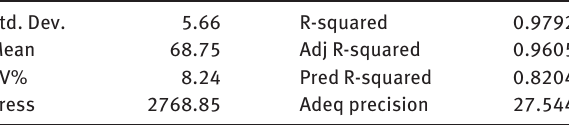
Table 5: Analysis of credibility about the model. Std. Dev.